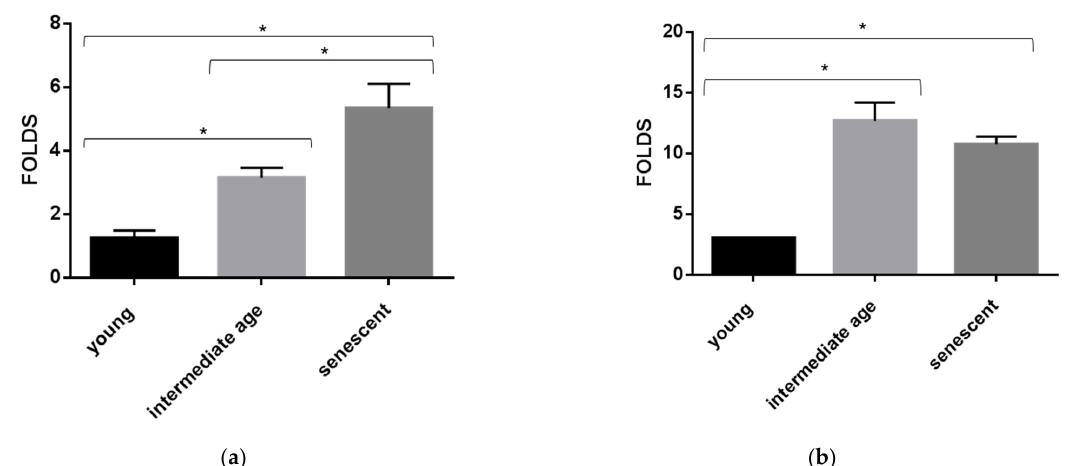
Figure 6. MiR-126a-3p levels variation in HUVECs undergoing senescence. Bar charts show sEVs ( a ) and intracellular ( b ) miR-126-3p levels in young, intermediate, and senescent HUVECs. Data were calculated by qRT-PCR and represent mean ± SD of three different experiments analyzed in triplicate. CTs (cycle thresholds) resulting from qRT-PCR analysis were normalized with miR-30a (EVs) and RNU6b (intracellular); levels were calculated with 2- Δ CT method and expressed as folds, with respect to lowest value registered. Comparison among multiple groups was analyzed by one-way analysis of variance, followed by Bonferroni’s post hoc test. * p < 0.01.